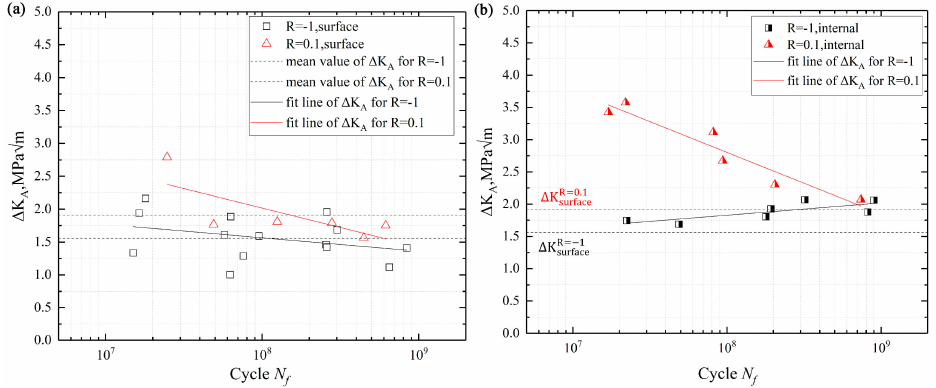
Figure 12. The ∆ K A vs. the fatigue life: ( a ) surface initiation and ( b ) internal